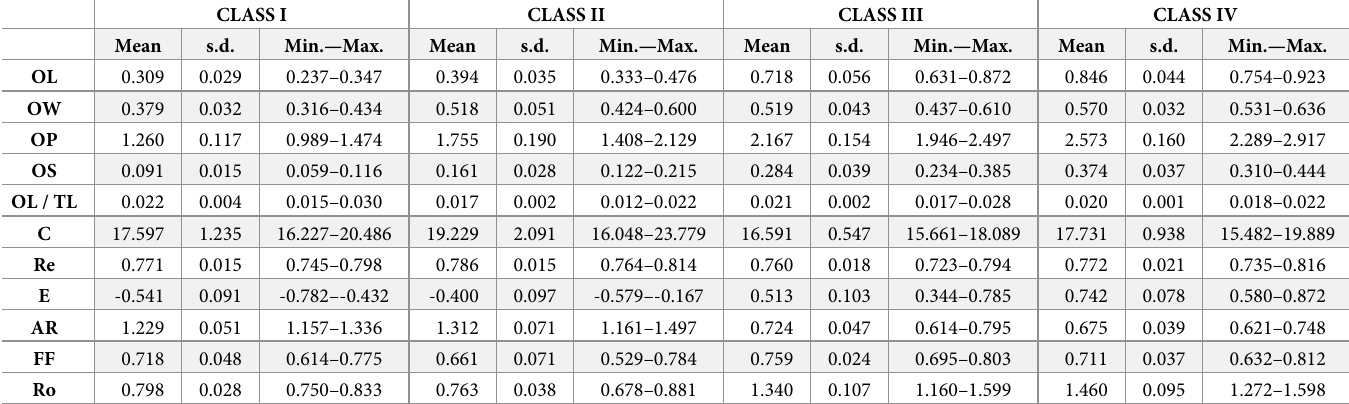
Table 1. Morphometric mean values of sagittae , standard deviation (s.d.) and minimums (Min.) and maximus (Max.) values divided for the size classes investigated: Maximum otolith length (OL, mm), the maximum otolith width (OW, mm), otolith perimeter (OP, mm) and otolith surface (OS, mm 2 ), the ratio of otolith length to the total fish length (OL/TL), circularity (C = OP 2 /OS), rectangularity (Re = OS/[OL × OW]), ellipticity (E = OL–OW/OL+OW), aspect ratio (AR = OW/OL%), form factor (FF = 4 π OS/OP 2 ) and roundness (Ro = 4OS/ π OL 2 ).